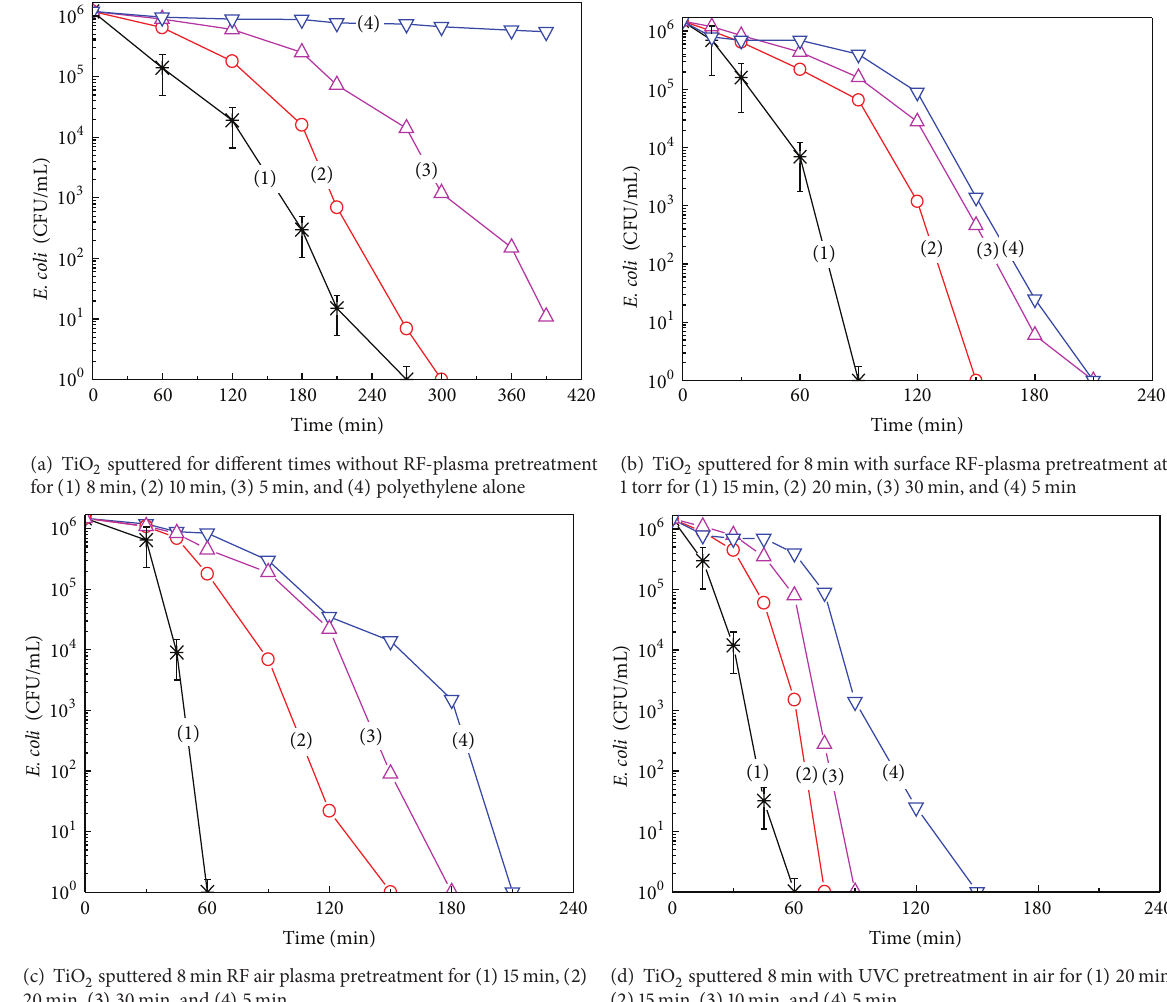
Figure 2: E. coli inactivation on TiO 2 sputtered on PE for 8 min irradiated with simulated solar light (52mW/cm 2